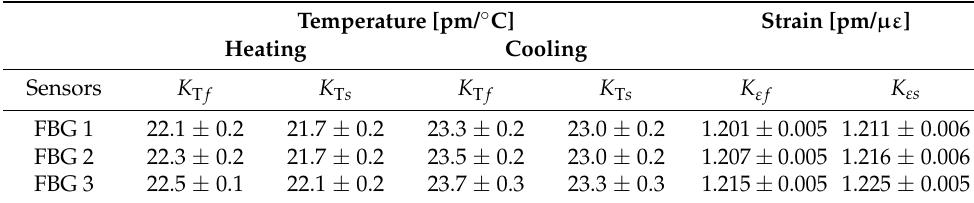
Table 1. PM-FBG temperature and strain sensitivities obtained from the experimental calibrations. Temperature [pm/ ◦ C]